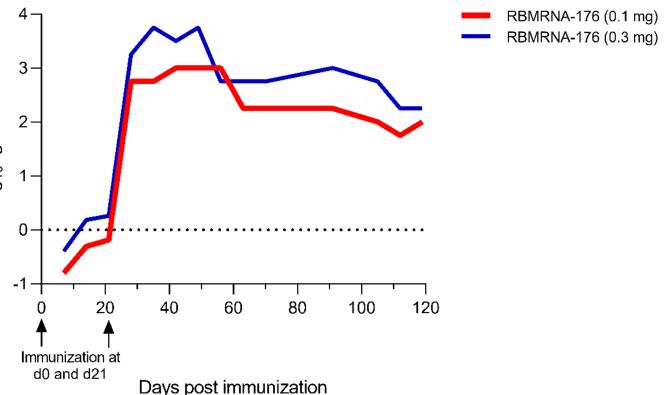
Figure 7. Humoral immune response in RBMRNA-176-vaccinated rhesus macaques. Rhesus macaques were vaccinated with 0.1 or 0.3 mg RBMRNA-176 at a 21-day prime-boost interval. From day 7 to day 119 after the first shot, the serum was collected daily and subjected to IgG ELISA assay.